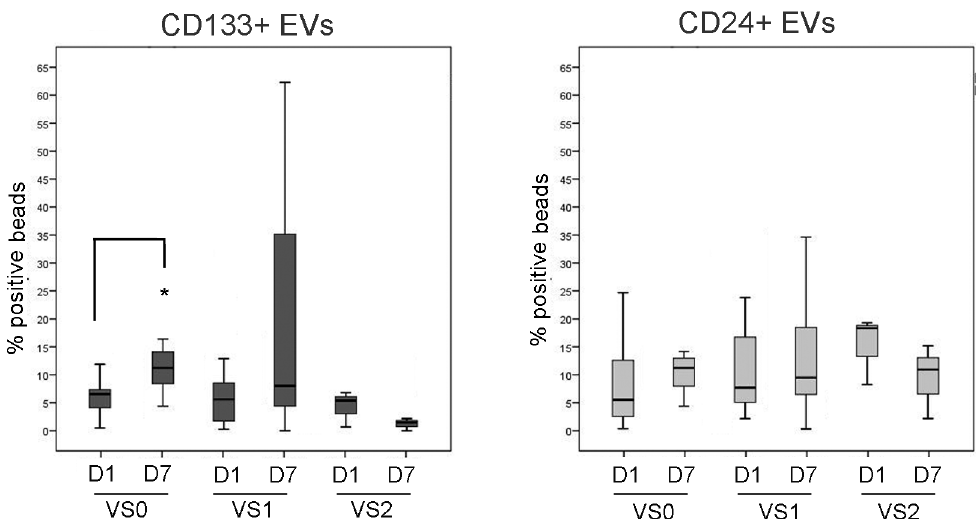
Figure 6. Median values of CD24 + and CD133 + EV levels in the urine of transplanted patients at day 1 and 7 after transplant (D1 and D7), divided according to the graft vascular lesions (VS), as described in Material and methods. No increase in urinary CD133 + EVs was observed in VS2 patients. Statistical analysis was performed as described in the Materials and methods section. *=p , 0.05.